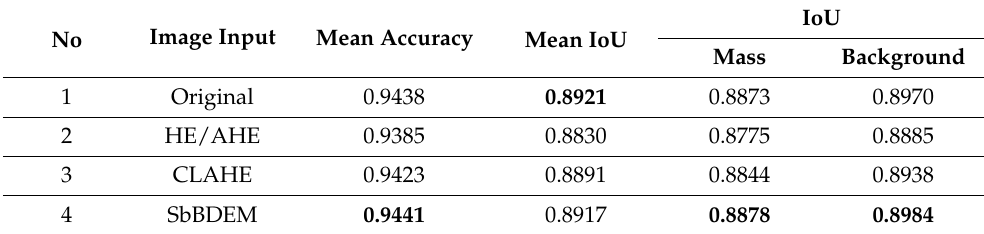
Table 3. Result of semantic segmentation for mass using different image input settings.